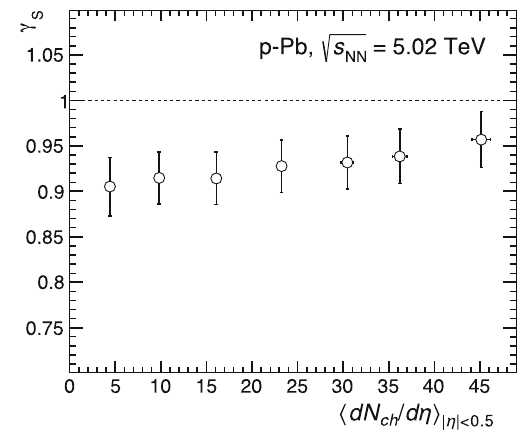
Fig. 7 Values of the strangeness non-equilibrium factor γ s as a func- tion of the charged particle multiplicity (cid:7) dN ch / d η (cid:8) | η | < 0 . 5